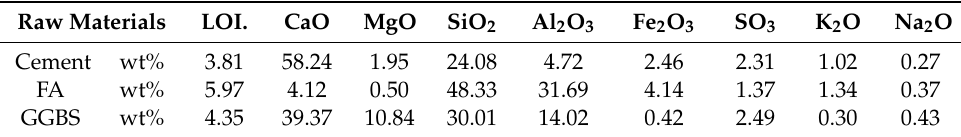
Figure 2. Molecular structure of diethanol-isopropanolamine (DEIPA).